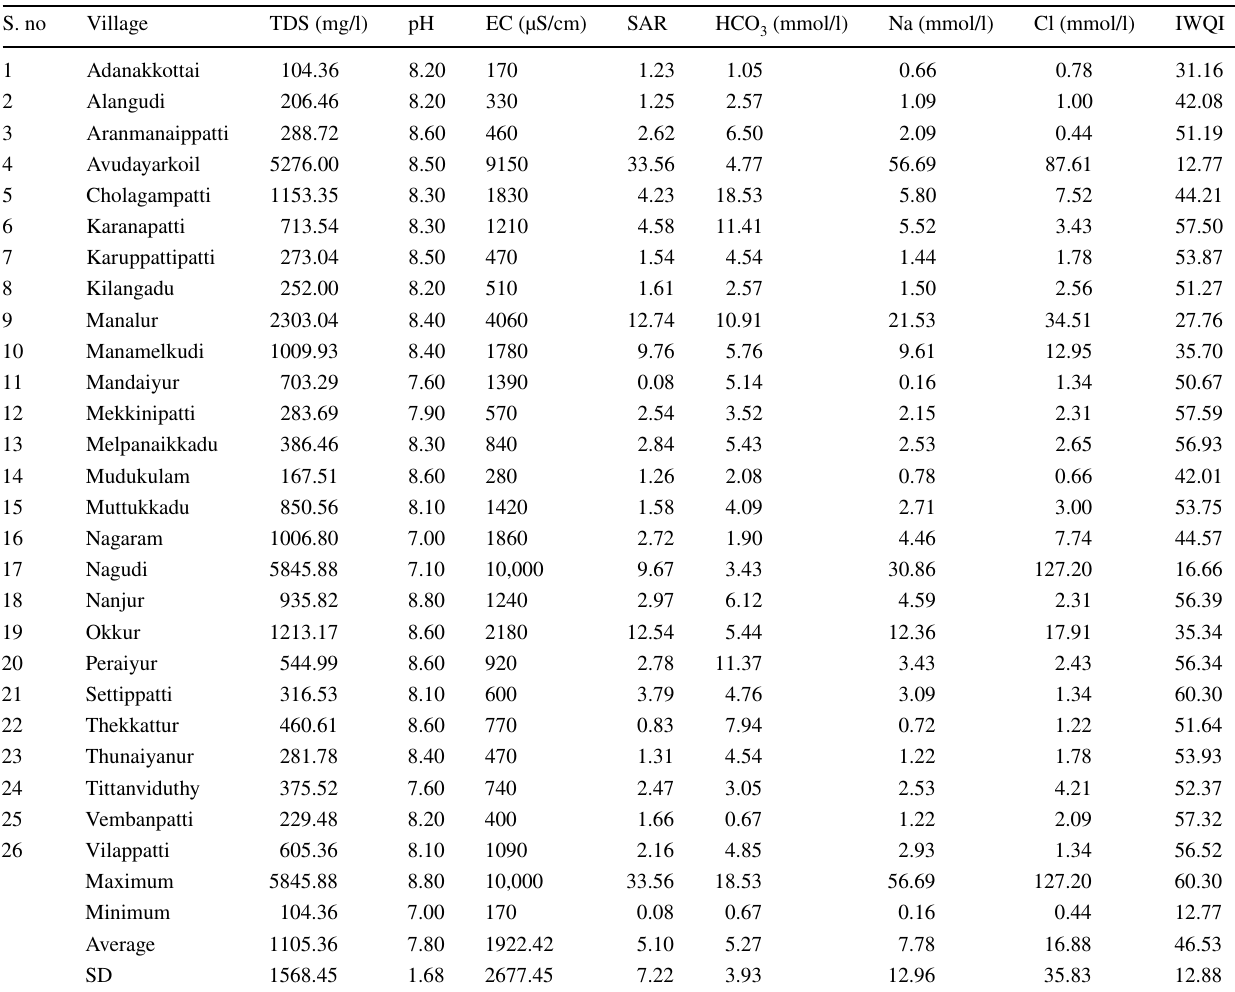
Table 1 Water quality and irrigational water quality index (IWQI) of Pudukkottai district—2000 S.